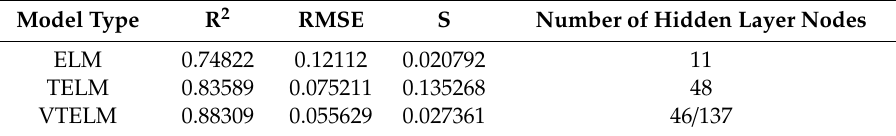
Figure 9. Experimental results of different models. Table 3. Results of copper content detection model test.